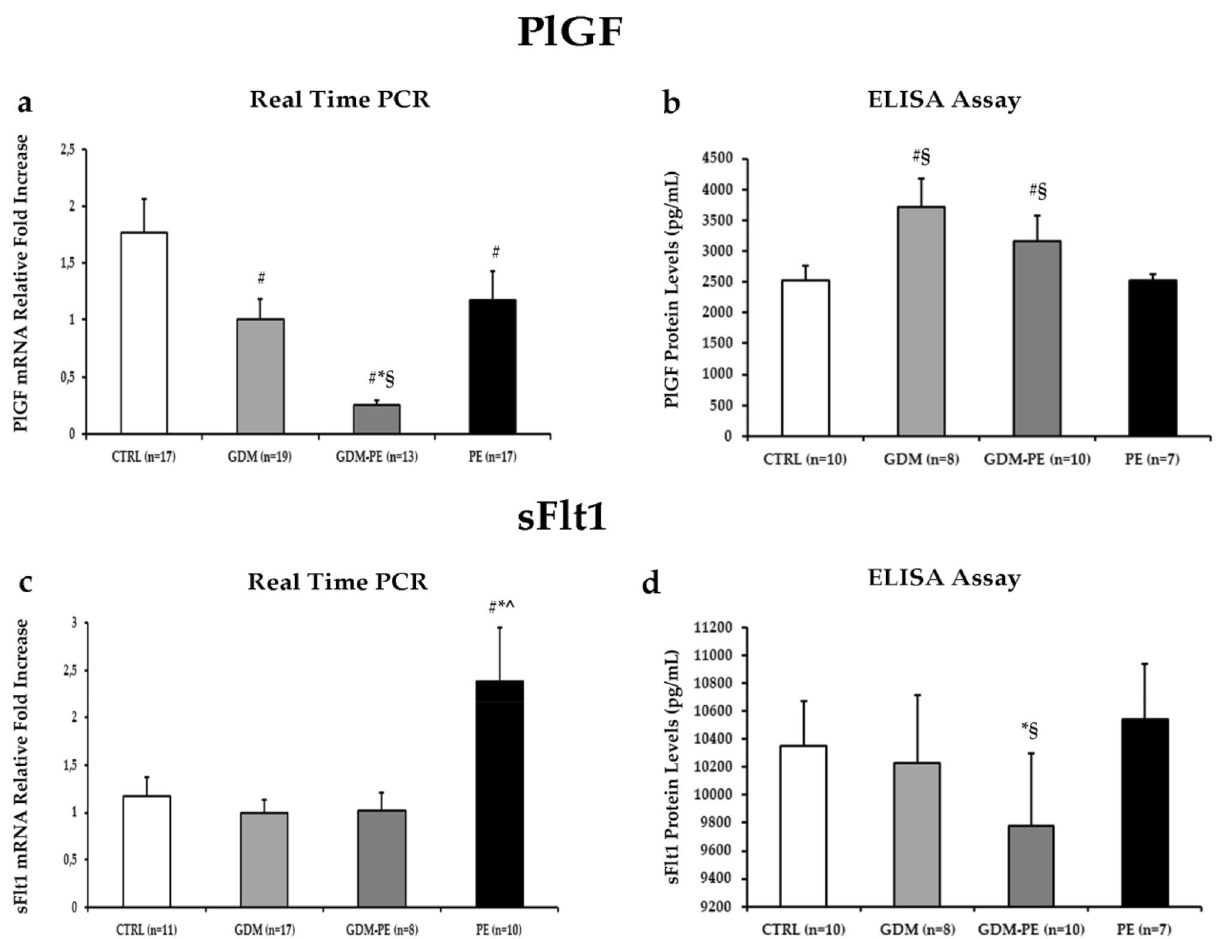
Figure 2. PlGF and sFlt1 gene and protein expression levels in CTRL, GDM, GDM-PE and PE placentae. ( a ) mRNA and ( b ) protein expression of PlGF in CTRL, GDM, GDM-PE and PE placentae; ( c ) mRNA and ( d ) protein expression of sFlt1 in CTRL, GDM, GDM-PE and PE placentae. Statistical significance has been considered as p < 0.05. # P < 0.05 versus CTRL; * P < 0.05 versus GDM; § P < 0.05 versus PE; ^ P < 0.05 versus